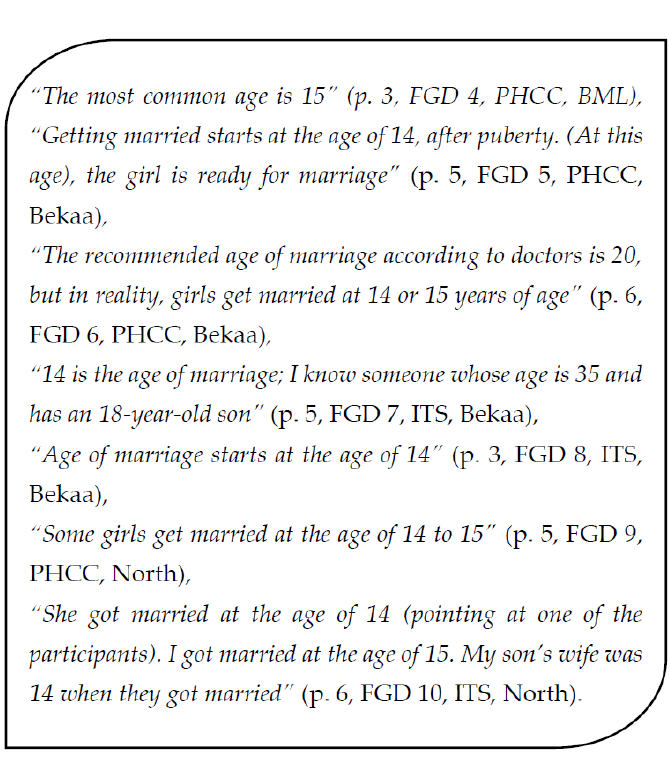
Figure 1. Quotes about age of marriage from selected focus group discussions (FGD); PHCC: primary health care center; ITS: informal tented settlements.